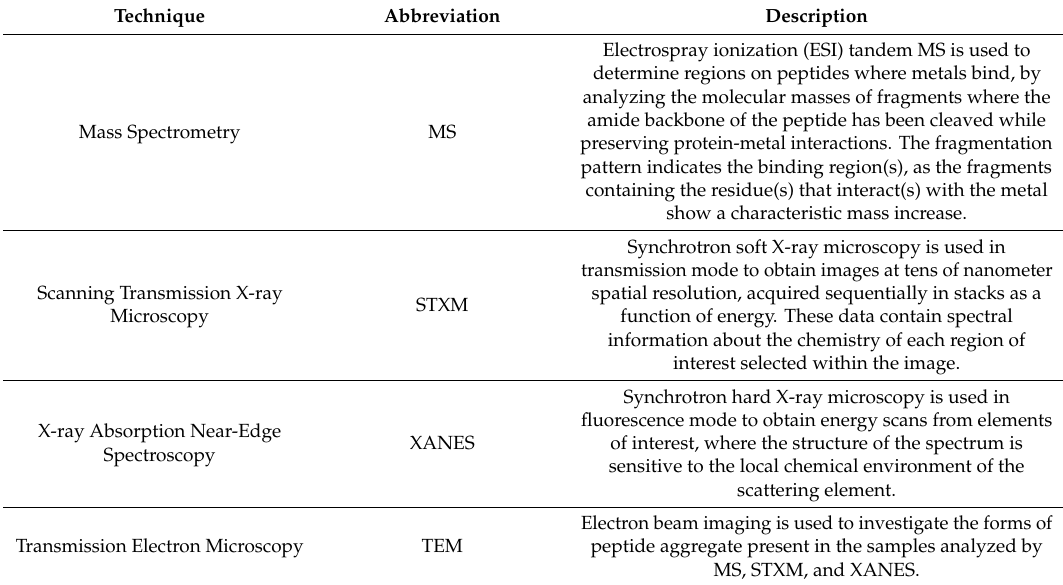
Table 1. Summary of primary